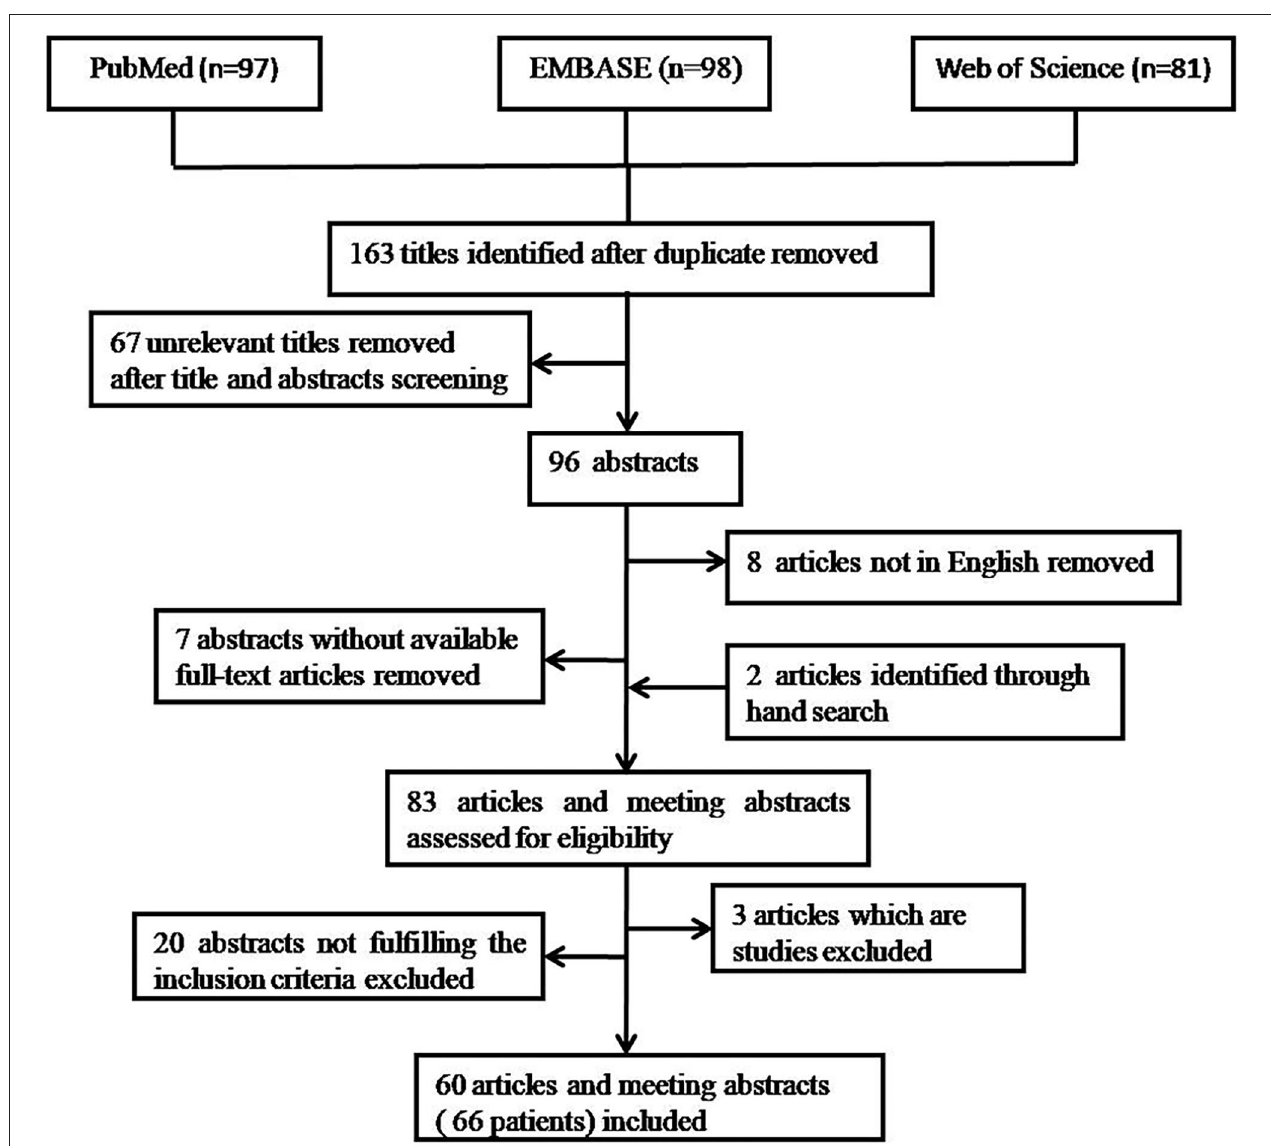
FIGURE 1 | Procedure of publication retrieval and inclusion and exclusion of cases displayed in a flow